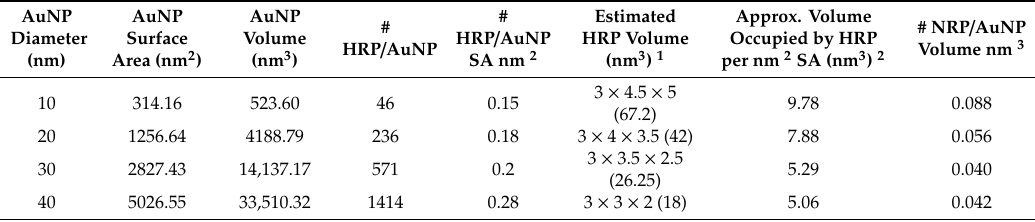
Figure 4. Kinetics of HRP on different sizes and configurations of AuNP ( a ) Turnover number ( k cat ) of free HRP and NP + HRP conjugates; ( b ) Michaelis–Menton constant ( K M ) as a function of the hydrodynamic diameter of the NP; ( c ) Plot showing the catalytic efficiency ( k cat / K M ) of free and size-controlled bionanoconjugates in comparison to a theoretical model (not accounting for secondary structure loss); ( d ) Representative TEM image of 80 nm AuNPs (NP 80); ( e ) Bright field TEM image of 60 nm AuSS (SS60); ( f ) Plot showing the k cat values of 60 nm NP (NP 60), 60 nm SS, and 80 nm NP; ( g ) Plot showing the K M values of 60 nm NP, 60 nm SS, and 80 nm NP. Reproduced with permission from ref. [31]. Copyright 2017 The Royal Society of Chemistry, London, United Kingdom. Table 3. Estimation of the number of horseradish peroxidase (HRP) per